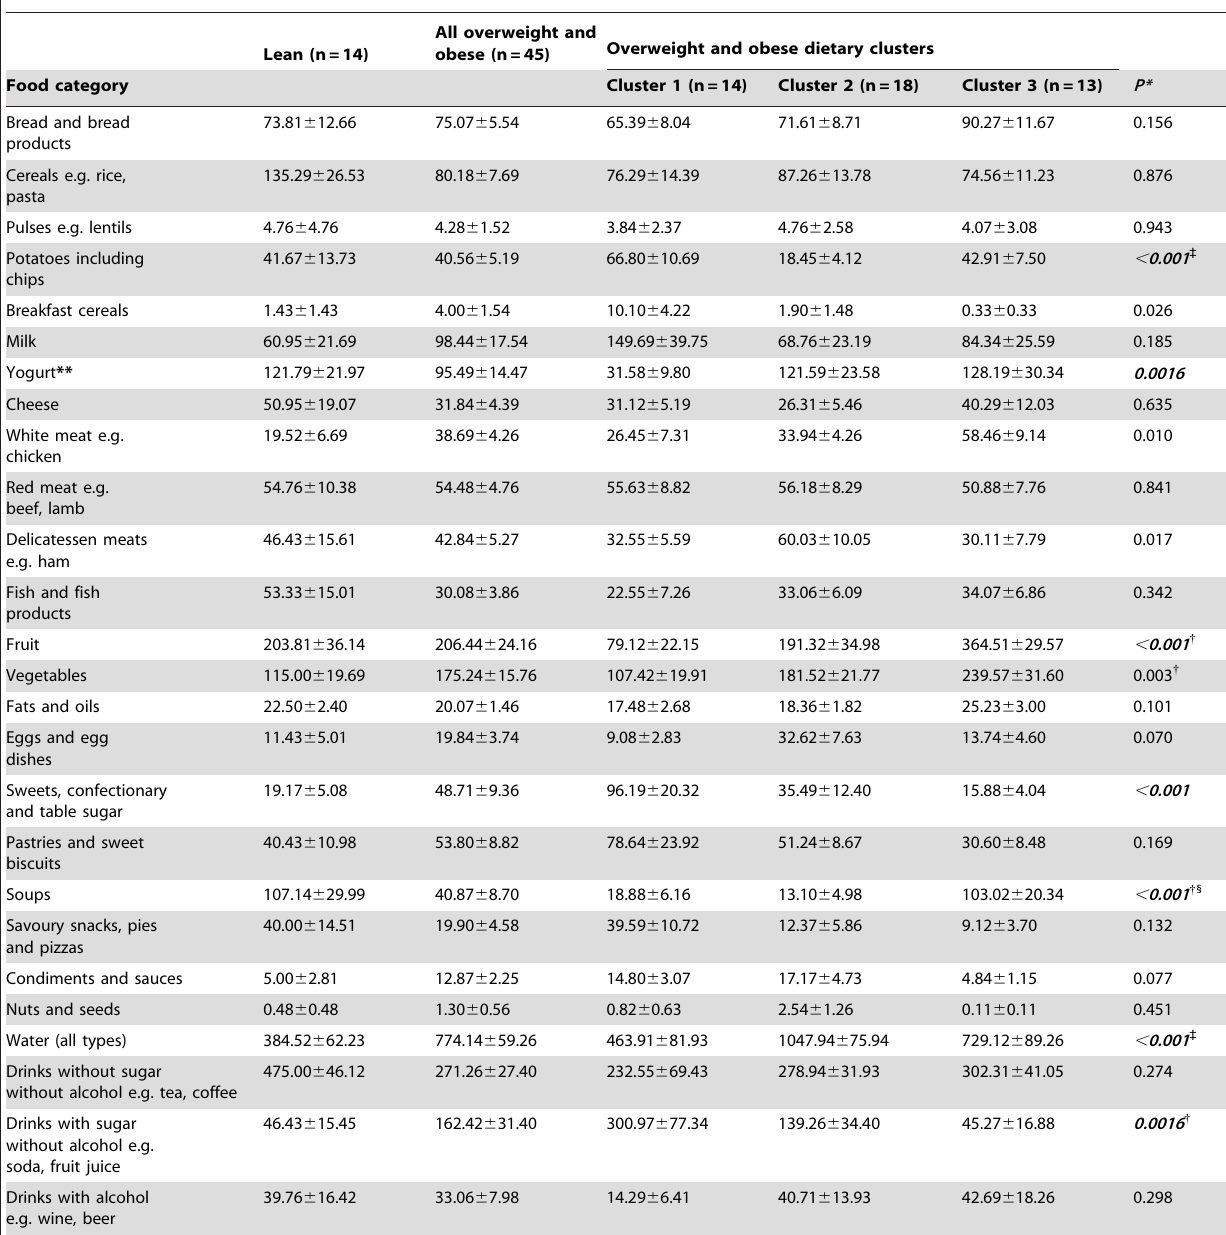
Table 2. Mean daily food consumption (grams) for lean, overweight/obese subjects and the 3 dietary clusters.